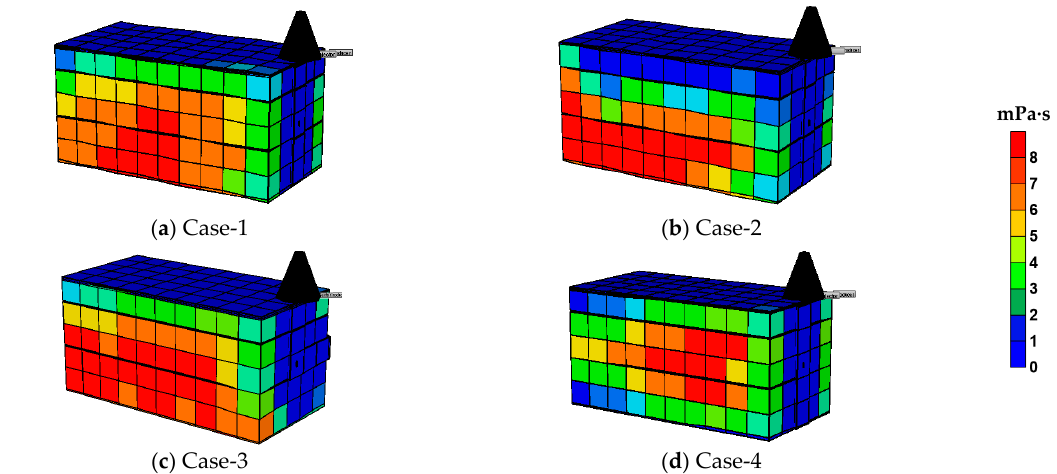
Figure 27. Oil viscosity comparison between different scattered fractures in the CO 2 soaking process.